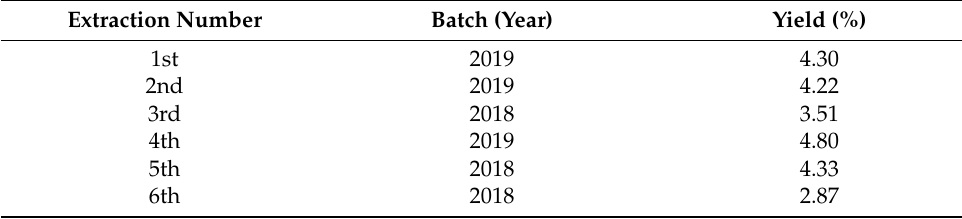
Table 1. Collagen extraction